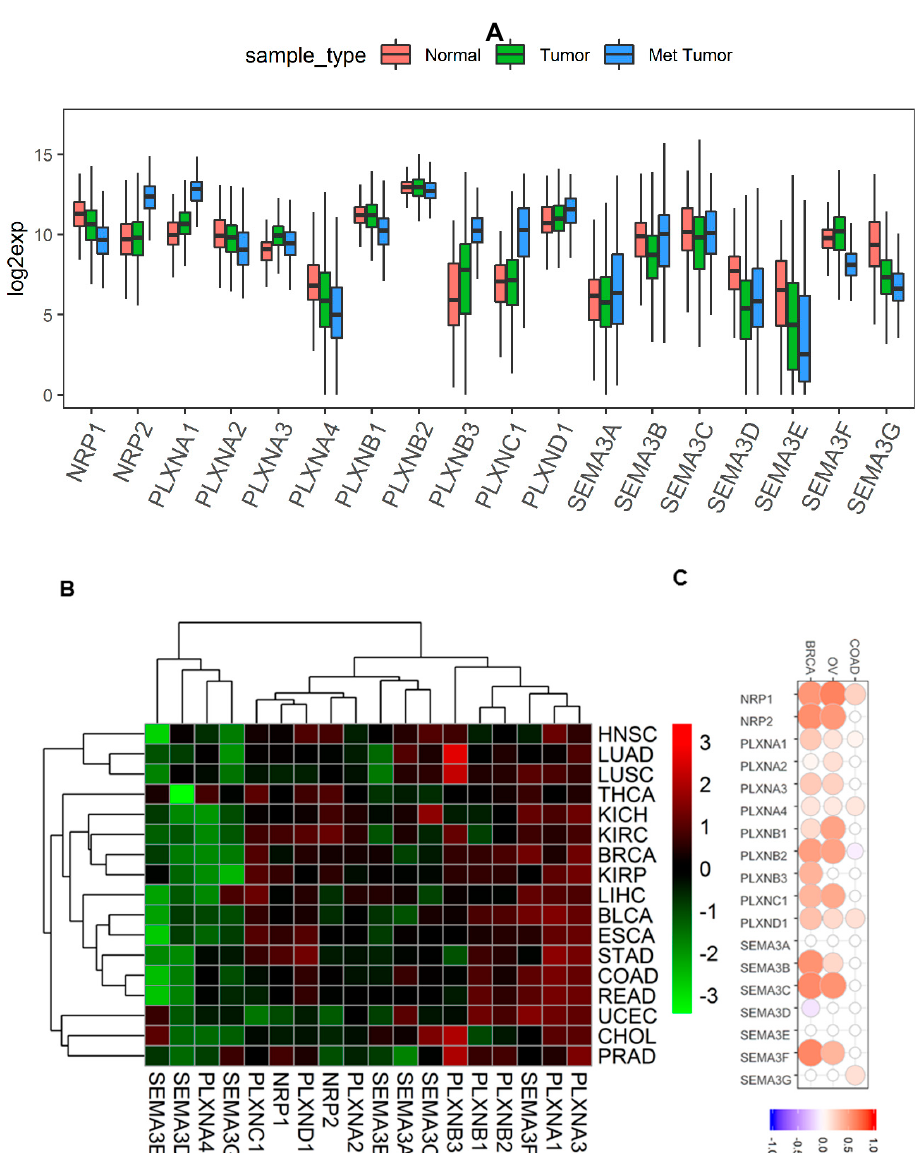
Figure 1. Expression levels of Class-3 semaphorins (SEMA3s) and their receptors neuropilins (NRPs) and plexins (PLXNs) in cancerous and adjacent normal tissues. ( A ). Boxplot to show the expression of SMEA3s and their receptors NRPs and PLXNs in adjacent normal ( n = 719), primary and blood tumors ( n = 9859), and metastatic tumors ( n = 395) across all 33 cancer types. p < 1 / (18 genes × 3 comparisons) = 0.018 was considered as significance. ( B ). Heatmap to show the expression difference of SEMA3s and their receptors NRPs and PLXNs comparing primary tumor to adjacent normal tissues based on log2(fold change) for 17 cancer types that have more than 5 adjacent normal samples. p < 1 / (18 genes × 17cancer types) = 0.003 was considered as significance. ( C ). Correlation matrix to show the association between mRNA and protein level expression of SEMA3s and receptors in breast, ovarian, and colorectal cancers. p < 1 / (18 genes × 3 cancer types) = 0.018 as significance. HNSC, head and neck squamous cell sarcoma; LUAD, lung adenocarcinoma; LUSC, lung squamous cell carcinoma; THCA, thyroid carcinoma; KICH, kidney chromophobe; KIRC, kidney clear cell carcinoma; BRCA, breast invasive carcinoma; KIRP, kidney papillary cell carcinoma; LIHC, liver hepatocellular carcinoma; BLCA, bladder urothelial carcinoma; ESCA, esophageal carcinoma; STAD, stomach adenocarcinoma; COAD, colon adenocarcinoma; READ, rectum adenocarcinoma; UCEC, uterinecorpusendometrioidcarcinoma; CHOL,cholangiocarcinoma; PRAD, prostate adenocarcinoma; OV, high-grade ovarian